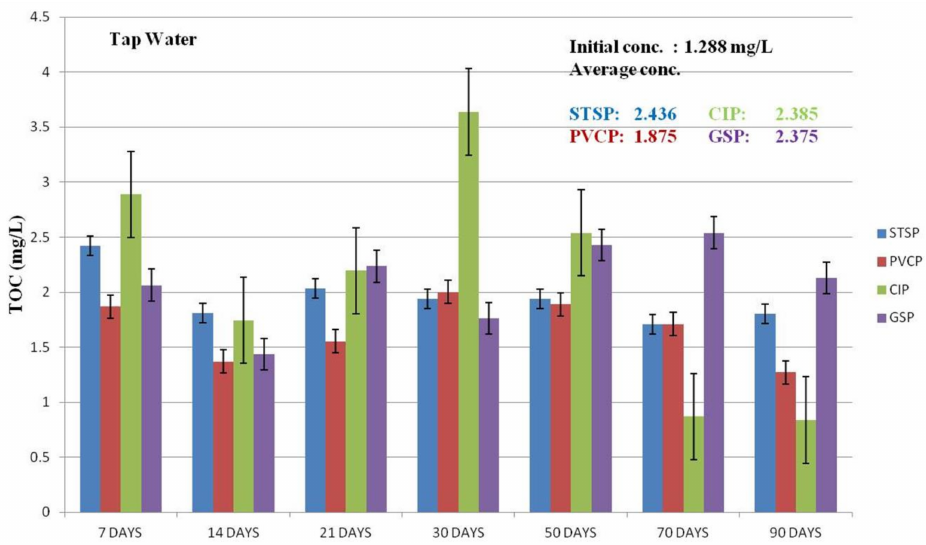
Figure 10. Total organic carbon for TW over time with standard error